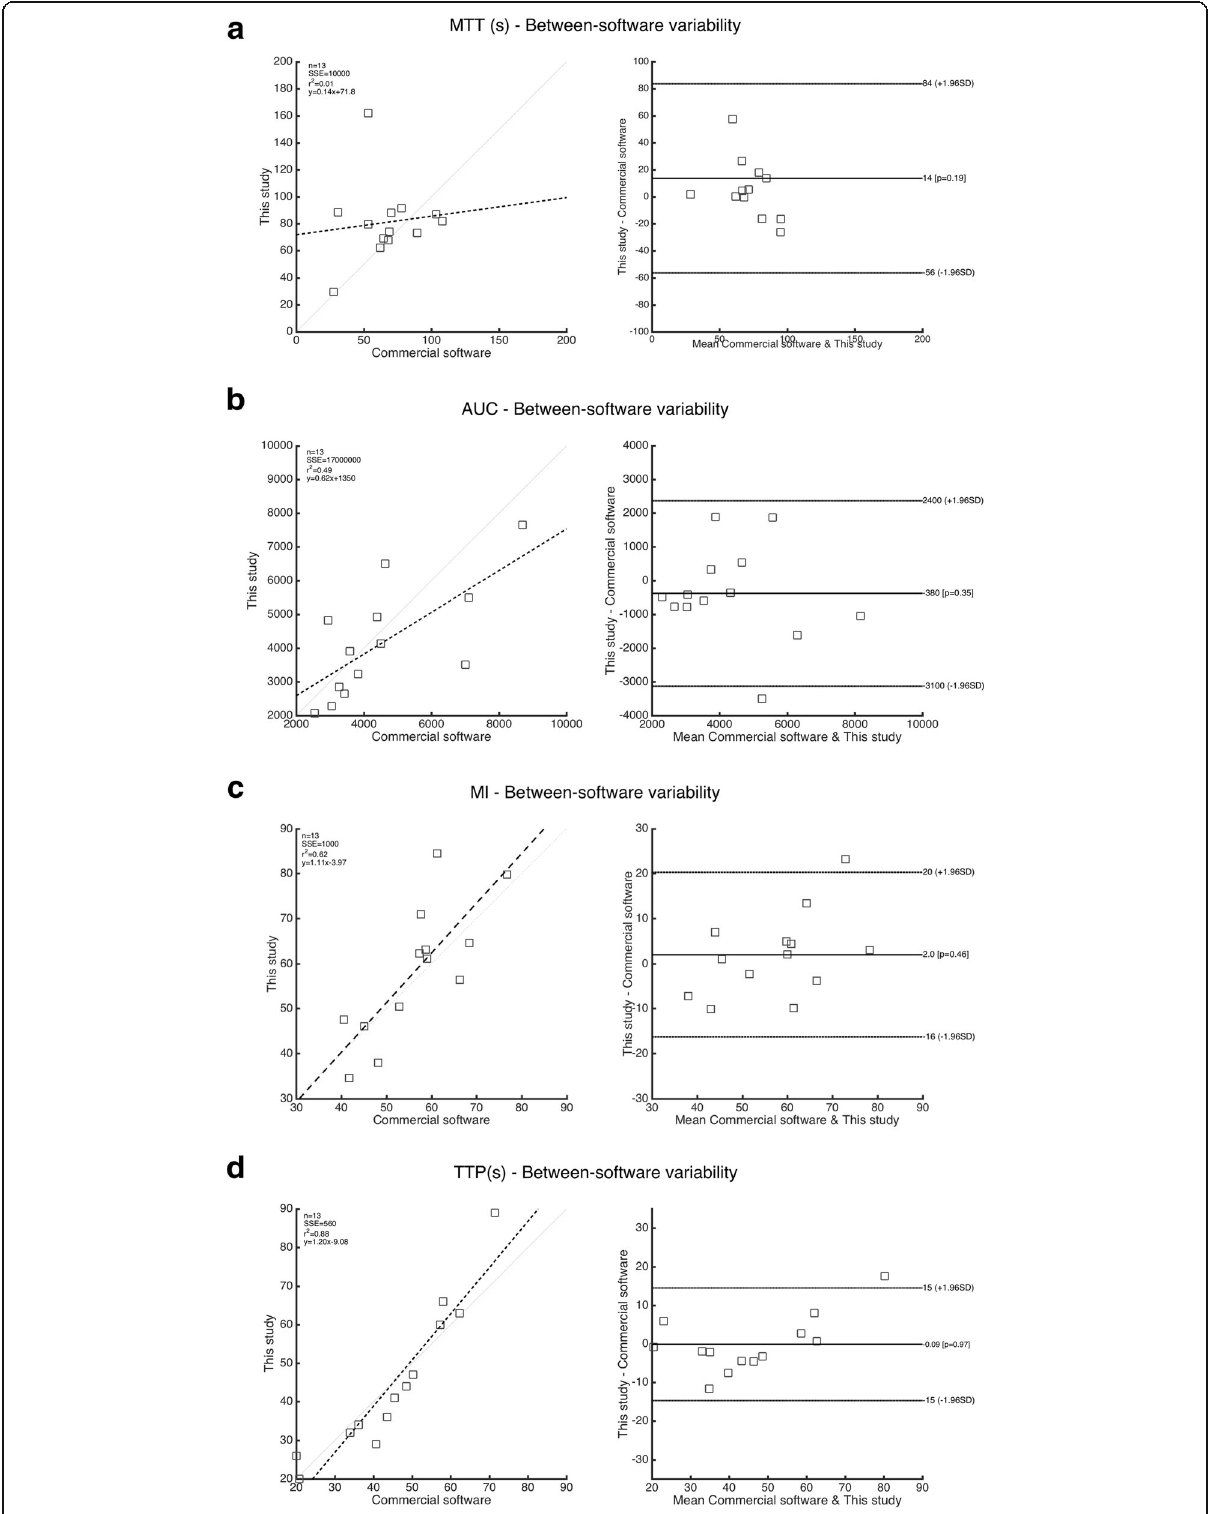
Fig. 5 Linear regression and Bland-Altman plots. a Mean transit time (s). b Area under the curve (a.u.). c Maximum intensity (a.u.). d Time to peak